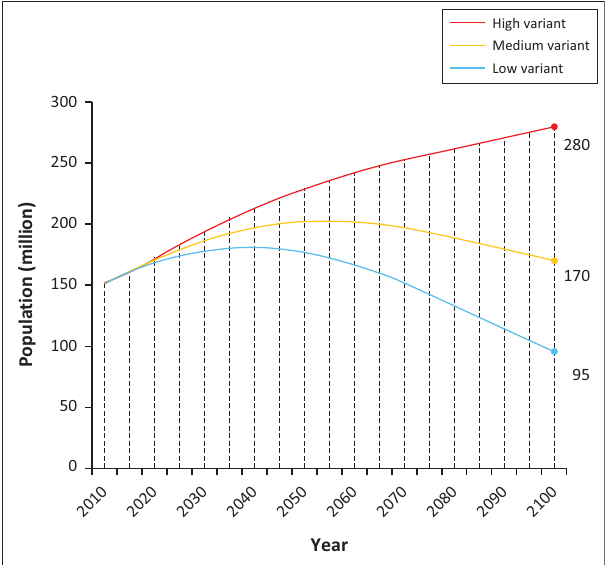
FIGURE 3: Population of Bangladesh (based on high, medium and low projection of the United